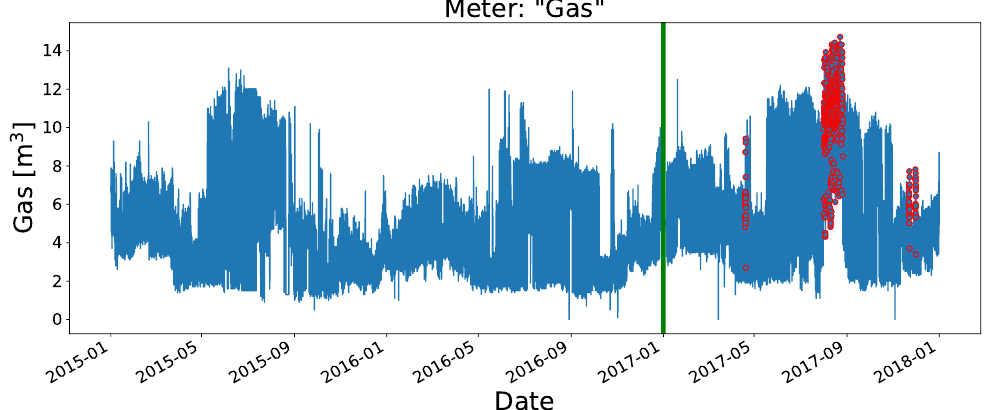
Figure 15. Graphical representation of the dataset of one meter used in the computational tests. The green line separates the train and test periods; the anomalies introduced in the test year are in